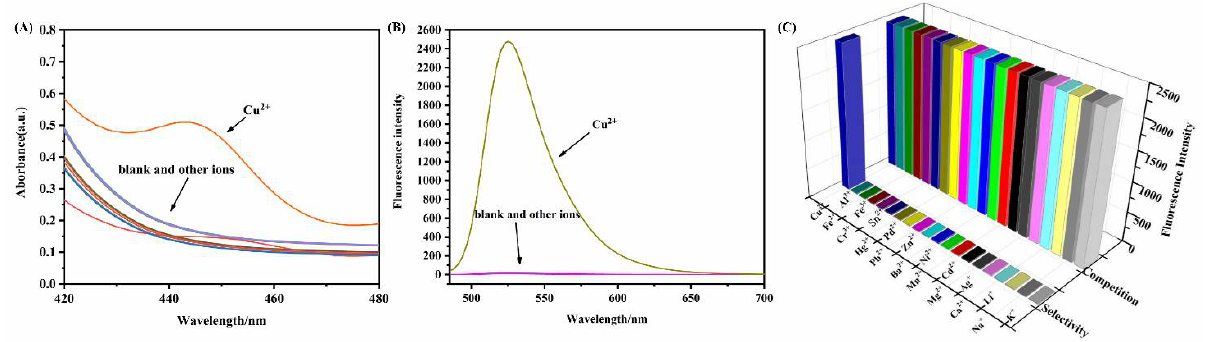
Figure 2. ( A ) Absorption spectrum of A5 (20.0 μM) in the presence of various metal ions: K + , Na + , Li + , Ca 2+ , Ag + , Mg 2+ , Cd 2+ , Mn 2+ , Ni 2+ , Ba 2+ , Zn 2+ , Pb 2+ , Pd 2+ , Hg 2+ , Sn 4+ , Cr 3+ , Fe 3+ , Fe 2+ , Al 3+ , and Cu 2+ (20.0 μM) in PBS buffer (10 mM, pH = 7.4)/EtOH (1:1, v / v ), λ ex = 440 nm. ( B ) Fluorescence spectrum of A5 (20 μM) in the presence of various metal ions: K + , Na + , Li + , Ca 2+ , Ag + , Mg 2+ , Cd 2+ , Mn 2+ , Ni 2+ , Ba 2+ , Zn 2+ , Pb 2+ , Pd 2+ , Hg 2+ , Sn 4+ , Cr 3+ , Fe 3+ , Fe 2+ , Al 3+ , and Cu 2+ (20.0 μM) in PBS buffer (10 mM, pH = 7.4)/EtOH (1:1, v / v ), λ ex = 440 nm. ( C ) Fluorescence spectrum of A5 (20.0 μM) and Cu 2+ (20.0 μM) in the absence and presence of various metal ions: K + , Na + , Li + , Ca 2+ , Ag + , Mg 2+ , Cd 2+ , Mn 2+ , Ni 2+ , Ba 2+ , Zn 2+ , Pb 2+ , Pd 2+ , Hg 2+ , Sn 4+ , Cr 3+ , Fe 3+ , Fe 2+ , Al 3+ , and Cu 2+ (40.0 µ M) in PBS buffer (10 mM, pH = 7.4)/EtOH (1:1, v / v ), λ ex = 440